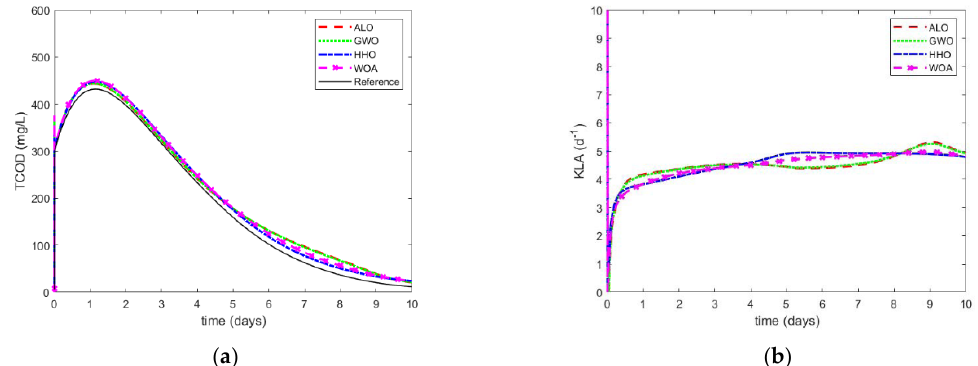
Figure 10. Tracking performance comparison in presence of parameter uncertainty: ( a ) TCOD control and ( b ) KLA signal.